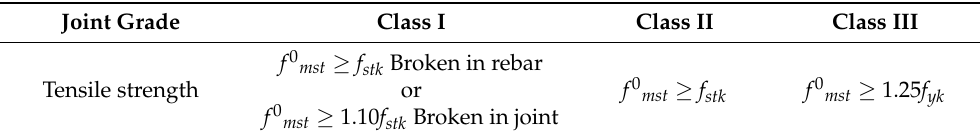
Table 1. Tensile strength requirements of steel bar joints.